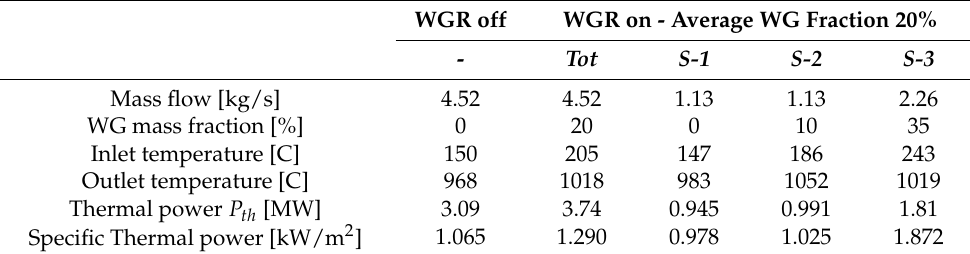
Figure 13. Average temperature profiles across the Cold RC with the WGR system application. Table 4. Model output of the Cold RC with the WGR system.